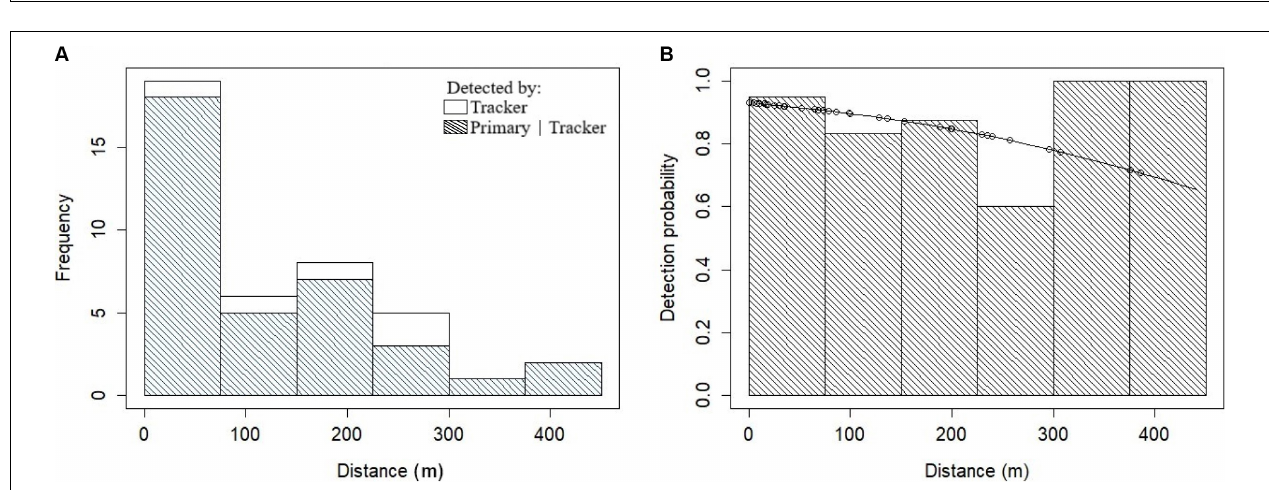
FIGURE 2 | Fitting the Heaviside’s dolphin detection function. (A) Histogram of the frequency distributions of the perpendicular distances (m) truncated to 350 m for Heaviside’s dolphin groups detected by the tracker platform (i.e., visual). Shading indicates duplicate detections made by the primary platform (i.e., acoustic). (B) The conditional detection function for the primary platform based on detection by the tracker platform. The solid line is the fitted MR-FI model for the Heaviside’s dolphin data and dots represent probabilities for individual detections.